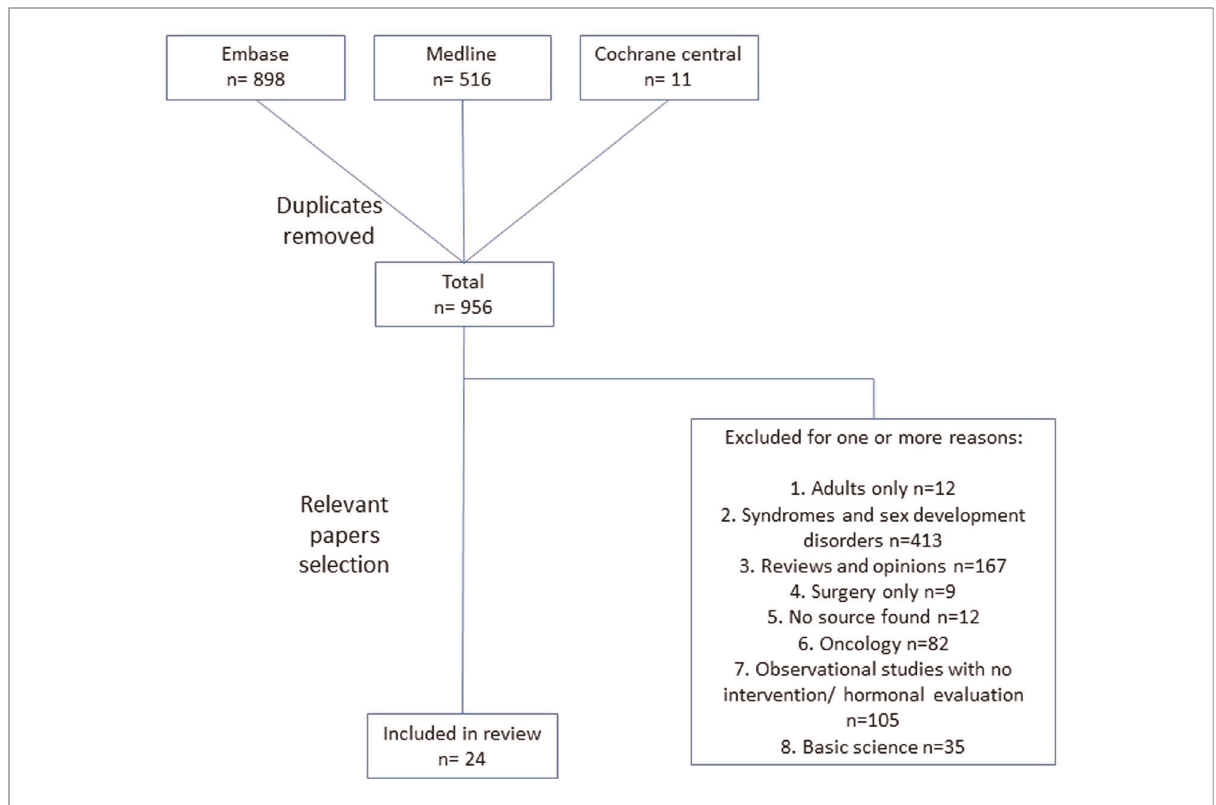
FIGURE 1 Flow chart of the review